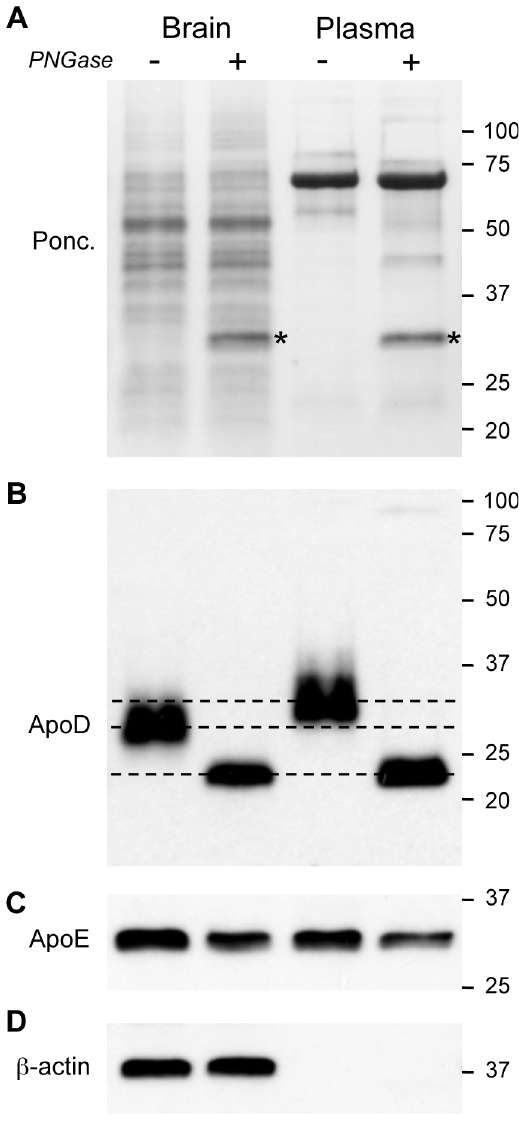
Fig 4. Comparison of brain and plasma apoD molecular weight and impact of N-glycan removal. Mouse brain and plasma samples were run on PAGE under conditions that yielded approximately equal apoD loading. Note that total protein loading was ~50% higher in the plasma samples based on Ponceau staining (A). Both brain and plasma samples with pre-incubated with PNGase ( “ + ” ) or buffer control ( “ - “ ) to assess the impact of N-glycans on overall MW (B). The broken lines in “ B ” clarify the migration distances of the different samples and indicates that N-glycans contribute more to MW for the plasma sample. Our comparision apolipoprotein (apoE) was not affected by PNGase, as predicted due to the lack of N-glycans on this protein (C). β -actin levels confirm equal sample loading amounts for the brain samples (D). * , Band due to added PNGase. PNGase, peptide N-glycosidase